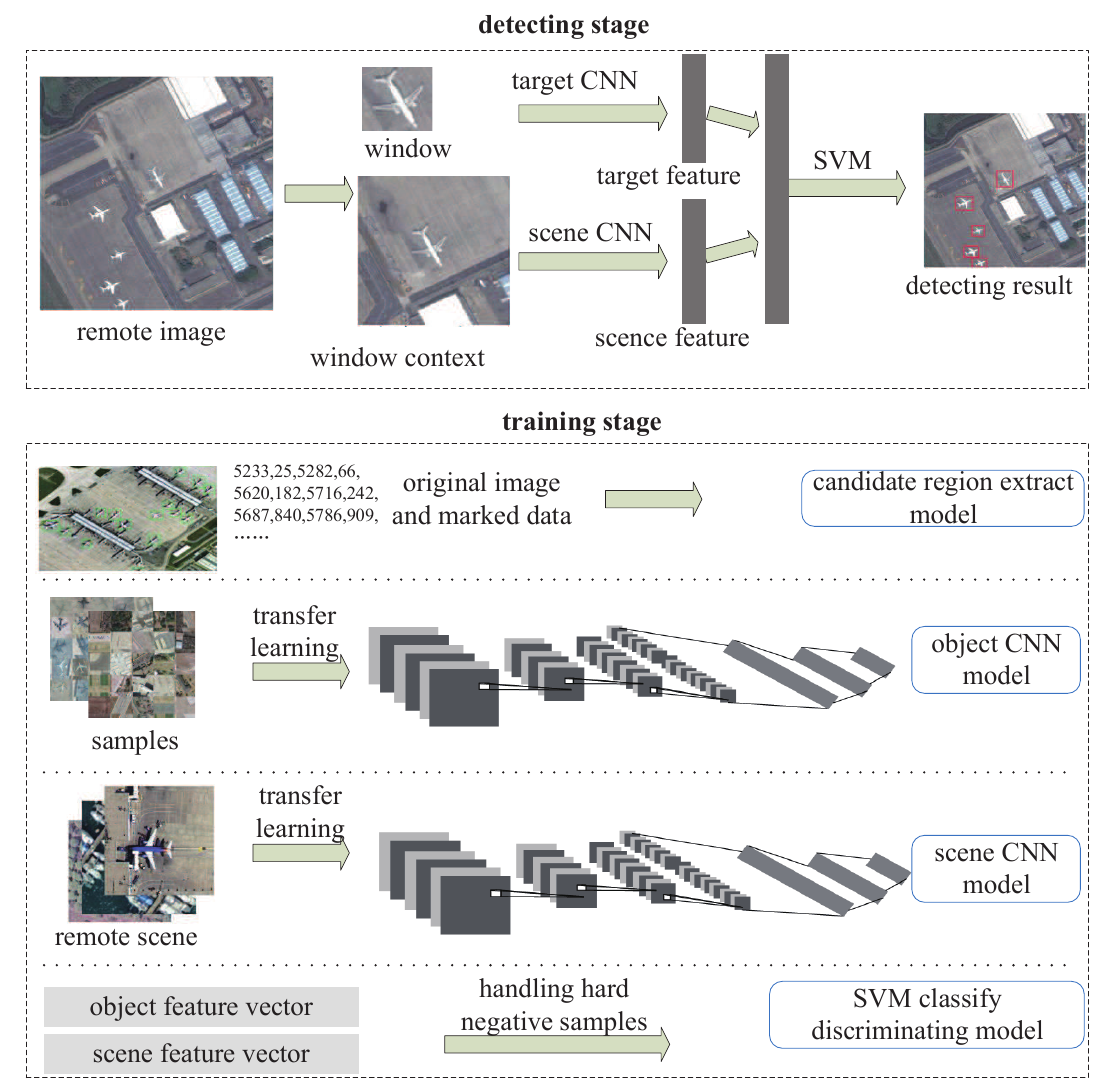
Figure 1. Proposed object detection